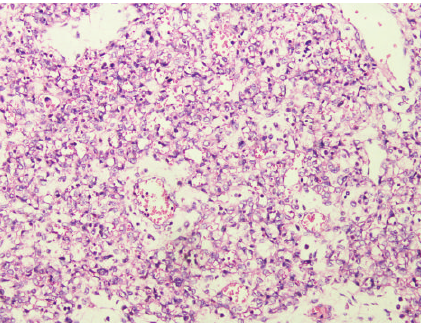
Figure 7: Microscopic examination of chorioangioma with lakes of blood vessels suggestive of angiomatous pattern. Hematoxylin and eosin stain. Original magnification ×40